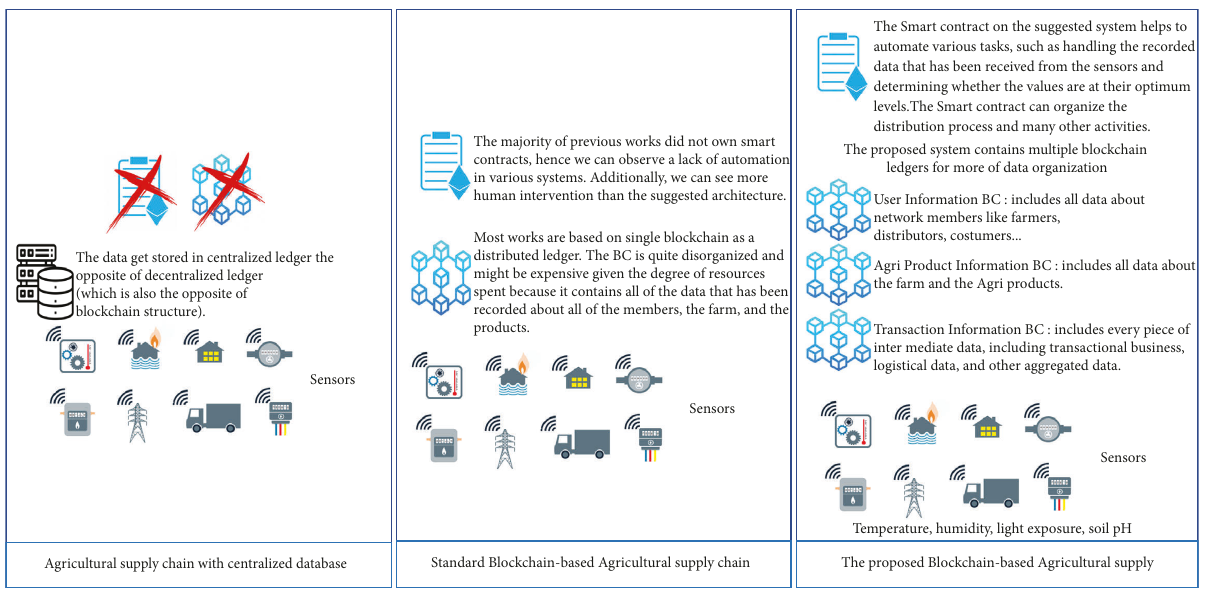
Figure 1: Comparison between existing agricultural schemes and the proposed